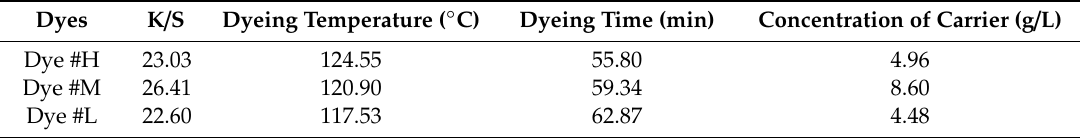
Table 6. Optimal conditions obtained by Box-Behnken design and the corresponding theoretical K/S values of samples dyed with used dyes.